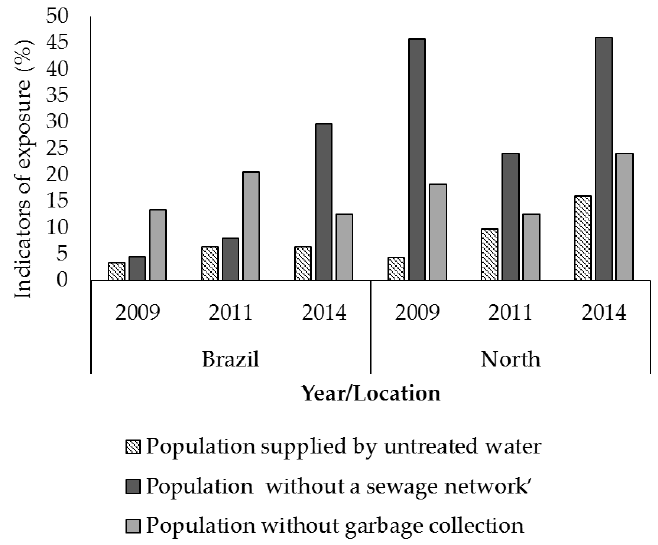
Figure 2. Indicators of exposure (DPSEEA framework) in Brazil and the northern region. Source: National Health Surveillance Agency, 2014 [16].